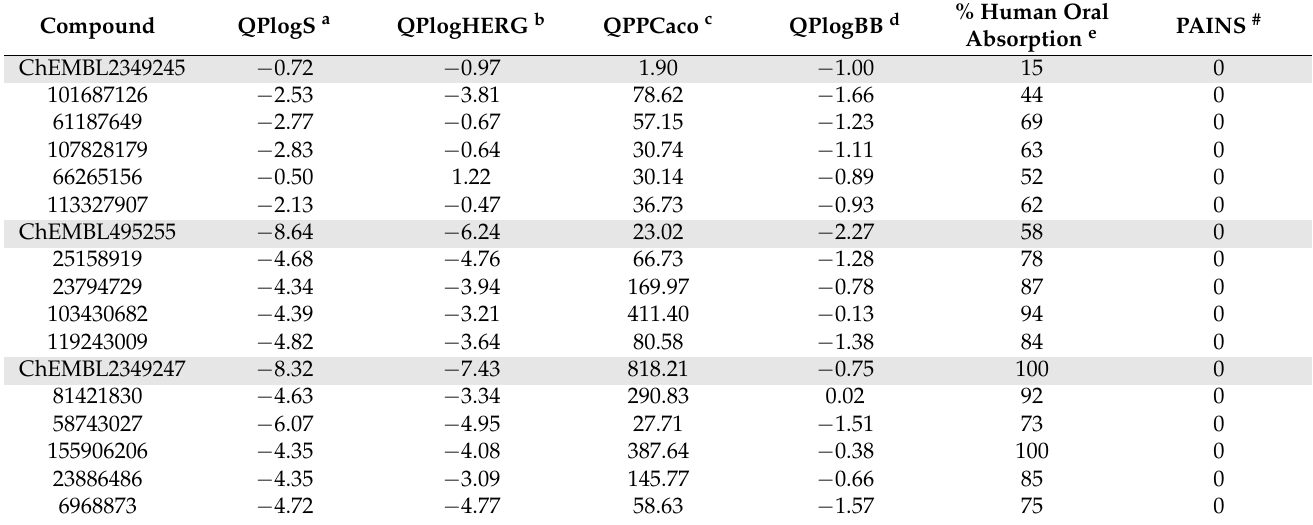
Table 3. Physicochemical descriptors of selected compounds computed with QikProp and structural alerts